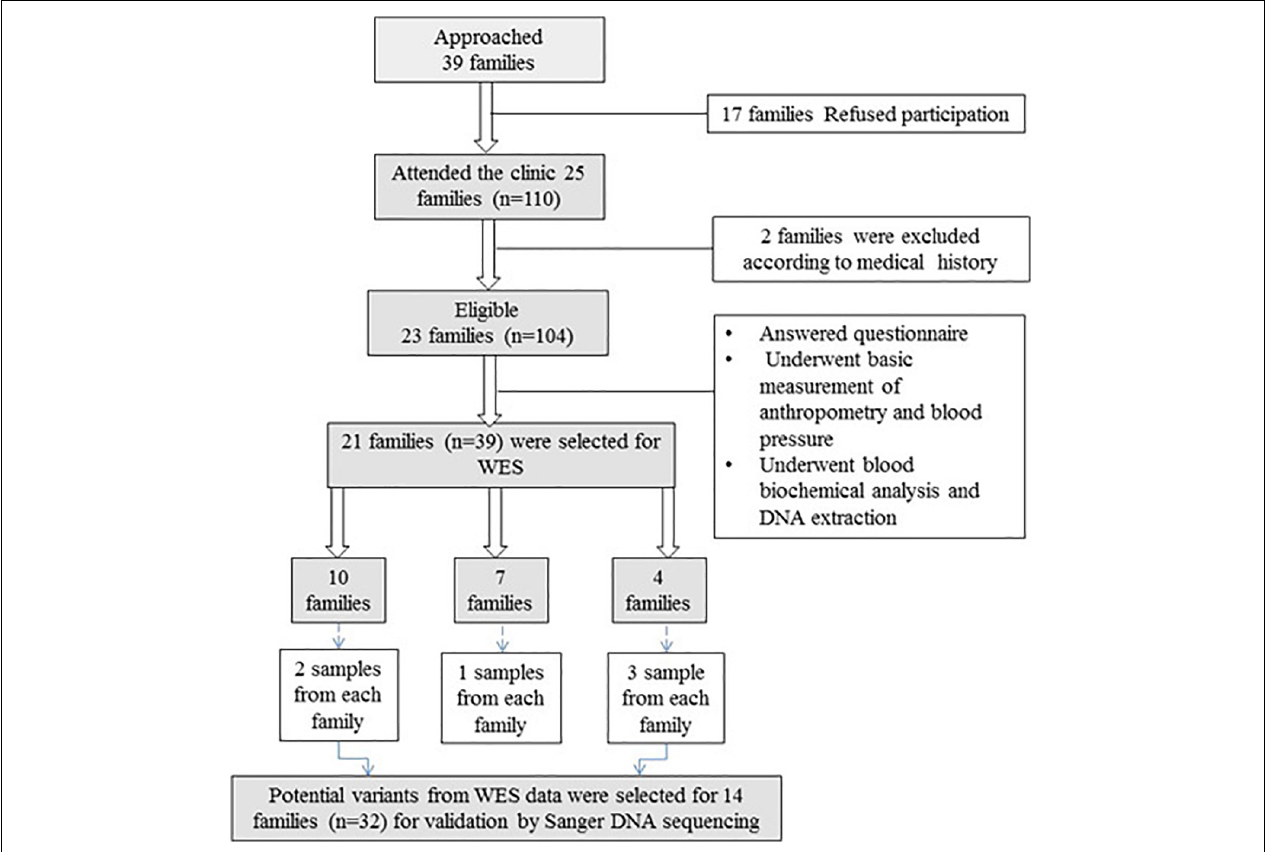
FIGURE 1 | Flowchart of recruitment of families with vitD deficiency. Thirty-nine families were approached, and 21 families ( n = 39) were included in WES. After variant filtration and prioritization, potential variants were validated in 14 families ( n = 32) using Sanger DNA sequencing.